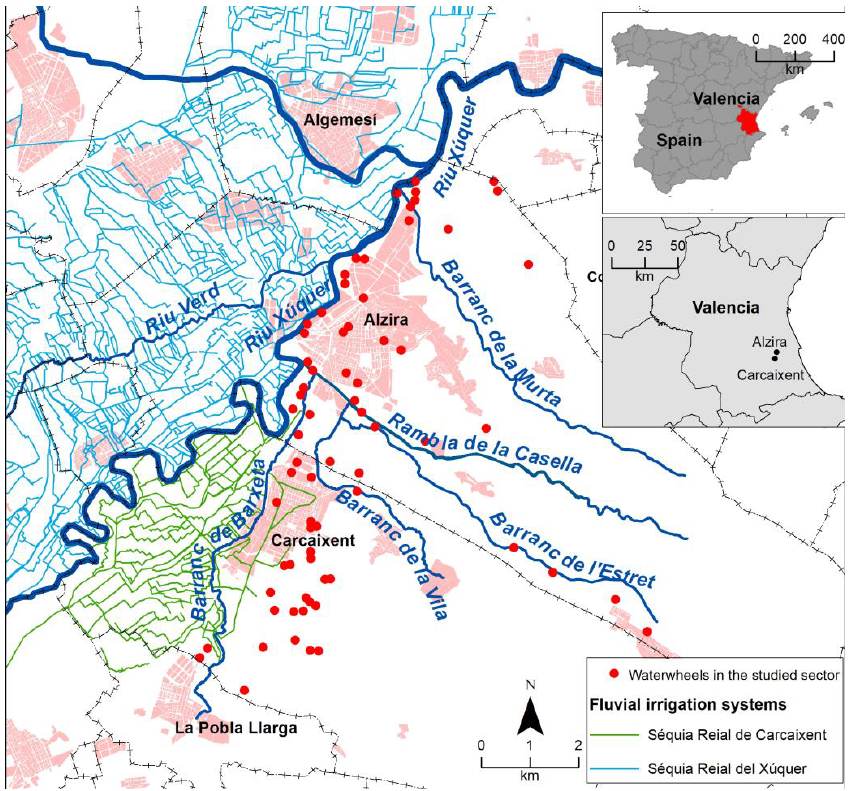
Figure 1. Spatial distribution according to height of the waterwheels identified in Testour and based on land registry parcels produced by the Topographical Service of the French Protectorate of the Tunisian Government in 1936.